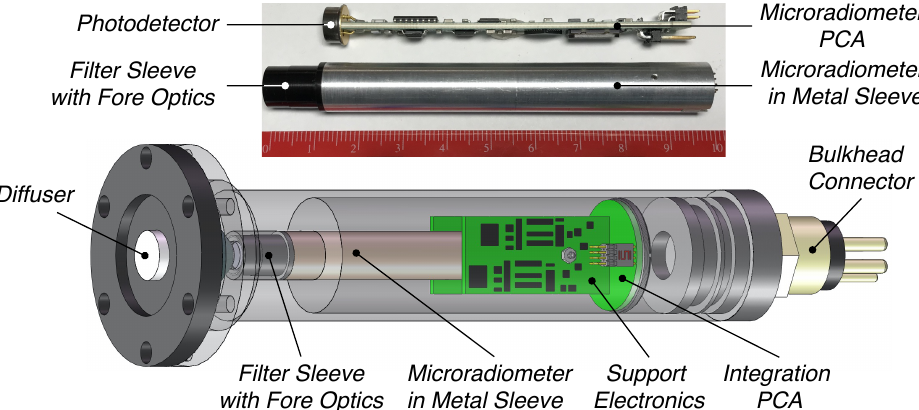
Figure 1. The two-sided microradiometer PCA with photodetector positioned (top) above a metal- sleeved unit with black front-end optics (red ruler to 10cm). A single-channel (PAR or fixed wave- length) irradiance sensor (bottom and not to the same scale) optimized for autonomous in-water platforms (e.g., an AUV) with 2.0in (5.1cm) diameter diffuser (cosine collector) attached to a 1.2in (3.0cm) diameter housing that is 7.2in (18.3cm) long. The total weight is 0.6lb